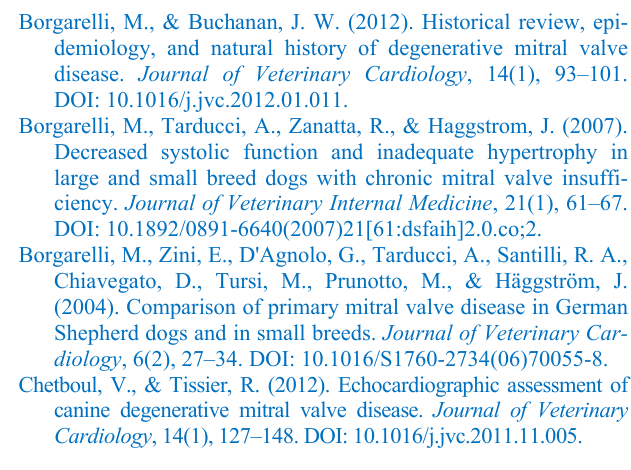
Blood leukogram of dogs with heart failure and the action of the drug “Bendamine” (M ± m; n = 10) Indicators